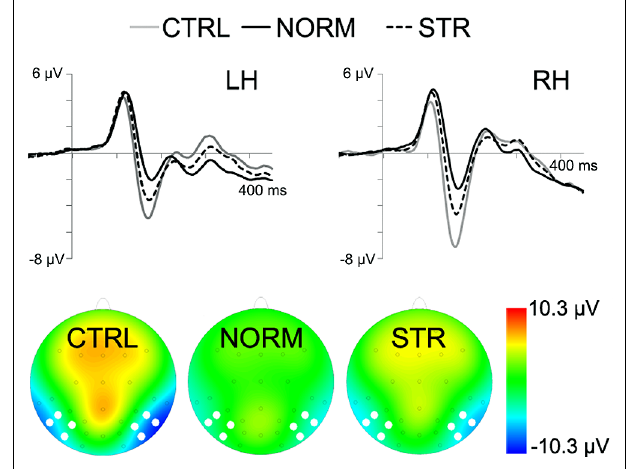
FIGURE 4 | Grand average ERPs for the CTRL (gray line), NORM (black continuous line) and STR (black dashed line). The bottom of the figure depicts the topographical maps of the activity with white dots marking the electrode locations, used for N170 analysis (10 ms time-window centered on the peak). Negativity is indicated by blue.